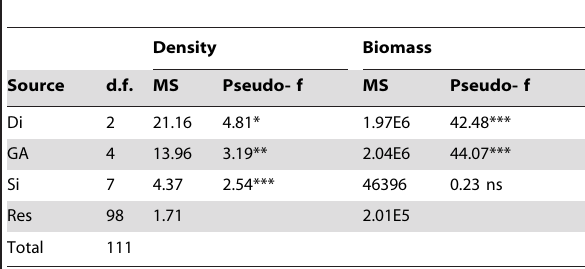
Table 3. PERMANOVA on density and biomass data of adult